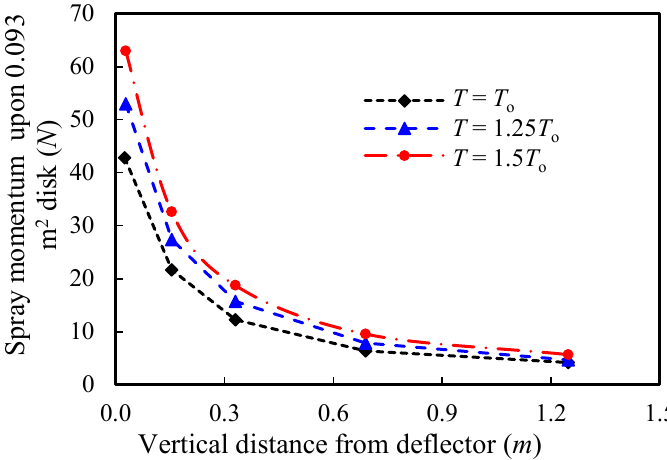
Figure 17. Spray momentum effect at 4.42 L/s [73].